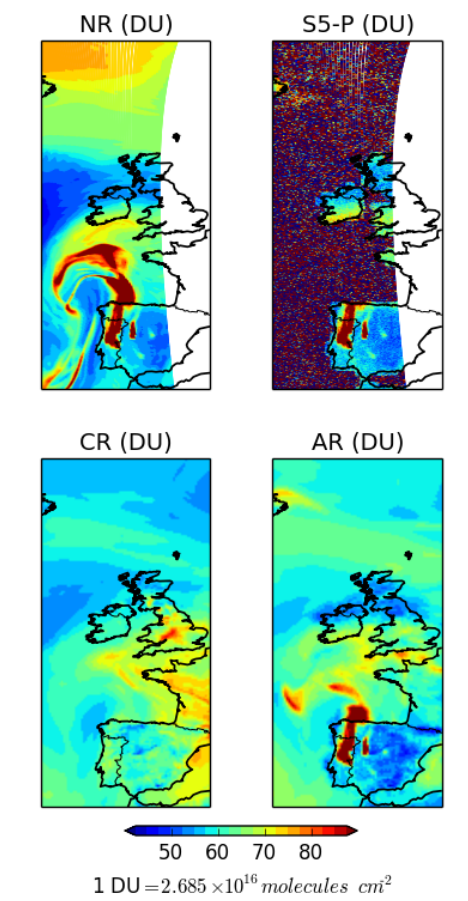
Figure 14. CO total column at 14:15UTC on 4 August 2003. DU indicates Dobson units. Top left panel: NR; top right panel: simu- lated S-5P observations; bottom left panel: CR; bottom right panel: AR. Red/blue colors indicate relatively high/low values of the CO total column.